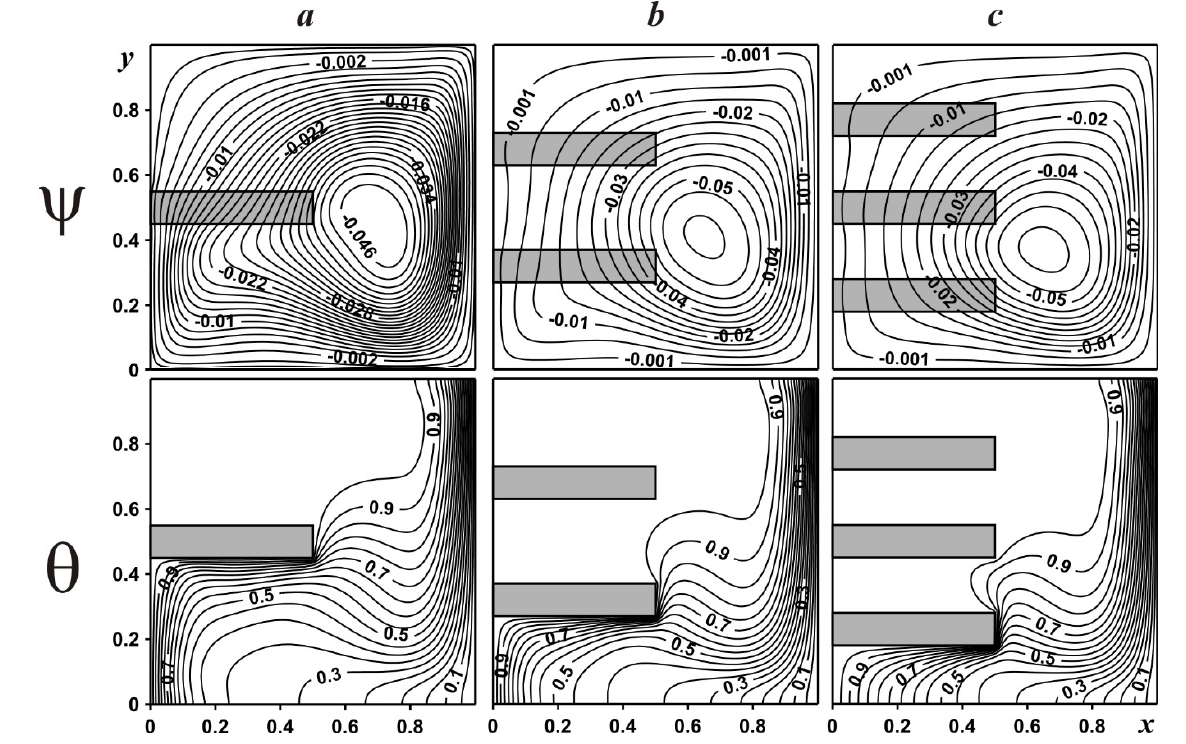
Figure 4. Streamlines and isotherms in a cavity with porous copper fins at Da = 10 − 4 : one fin ( a ); two fins ( b ); three fins ( c ).